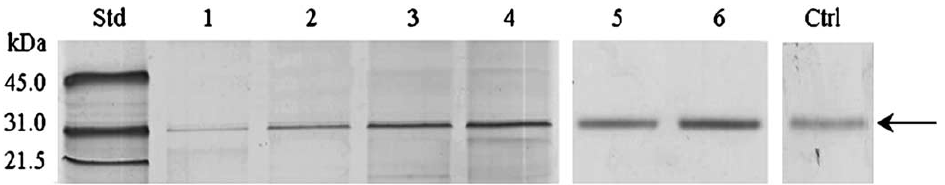
Fig. 3. Erythropoietin protein, immunoprecipitated and subsequently immunologically detected by Western blot, in representative serum (lane 1), milk (lane 2), NoCancer and Cancer NAF samples (lane 3 and 4, respectively), MCF-7 and BT-549 cancer cells (lane 5 and 6, respectively). In lanes Std and Ctrl, the standard proteins with their molecular masses expressed in kDa and a loading control of Epo, are respectively visualized. The arrow indicates the position of Epo of molecular mass of about 30 kDa.